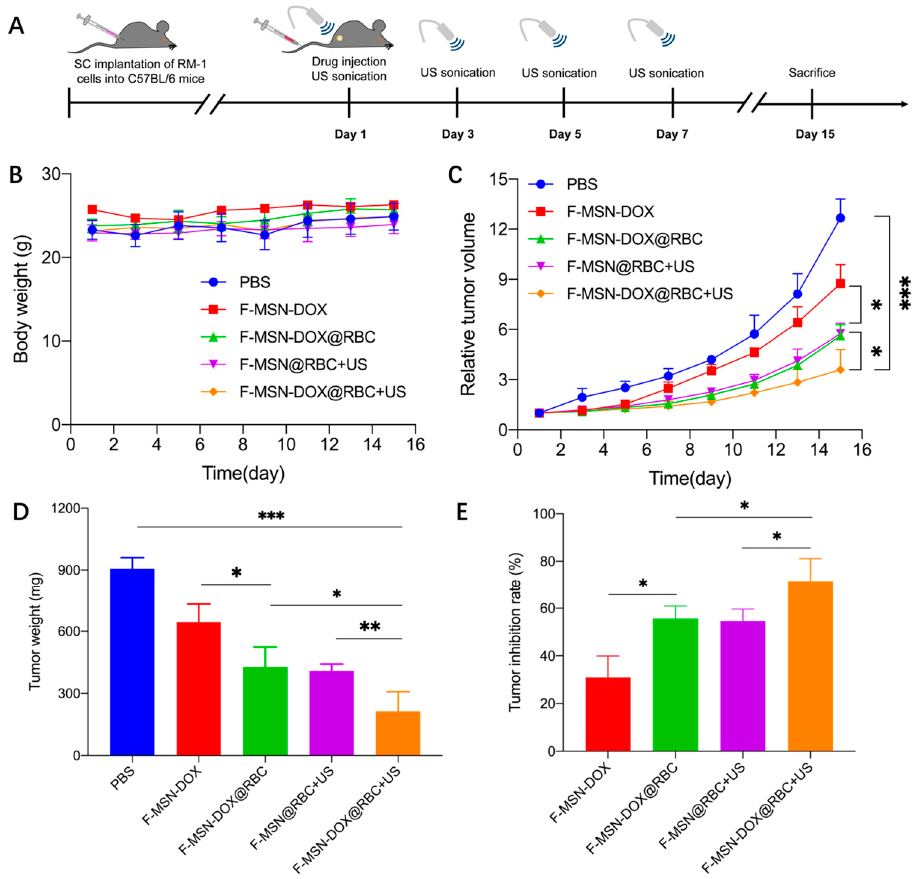
Figure 6. Anti-tumor e ffi cacy assessment. ( A ) The anti-tumor experimental fl ow chart. ( B ) The body weight changes of di ff erent groups. ( C ) The relative tumor volume tracing. ( D ) The tumor weight with di ff erent treatments. ( E ) The RM-1 tumor inhabitation rate. *** p < 0.001, ** p < 0.01, * p < 0.05, (n = 6).